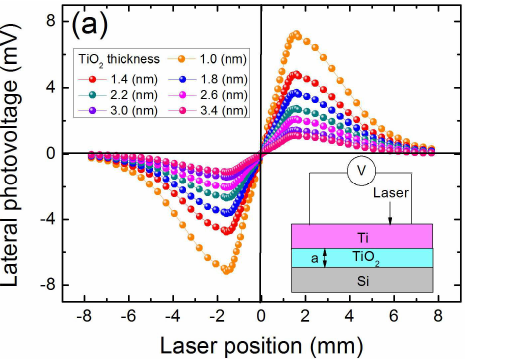
Figure 6. (a) LPV measurement in MOS structures of Ti(6.2 nm)/TiO /Si with different 2 TiO thickness. (b) LPV sensitivities as a function of TiO thickness in Ti(6.2 nm)/TiO /Si 2 2 2 structures. Here the contacts’ distance is 3.2 mm, and the laser wavelength and power are 632 nm and 3 mW respectively. Solid line is the plot of Equation (20), where the = 0.3 (nm) and α = 1.25 parameters are chosen as α 0 t